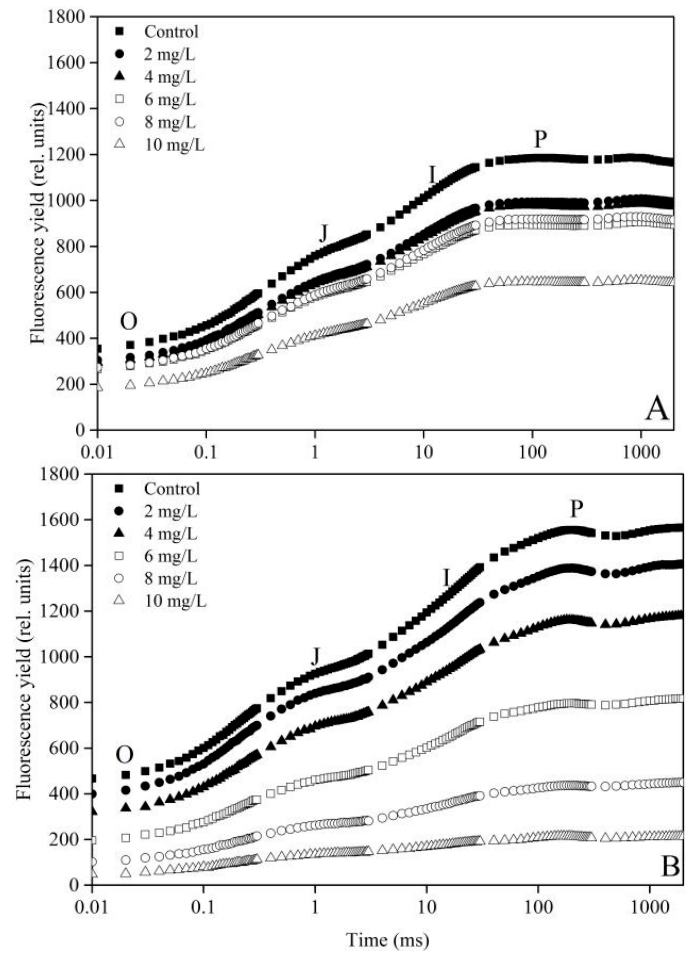
Figure 2. Rapid increase in fluorescence transients for C. vulgaris ( A ) and P. tricornutum ( B ) exposed to La(NO 3 ) 3 ·6H 2 O for 96 h.